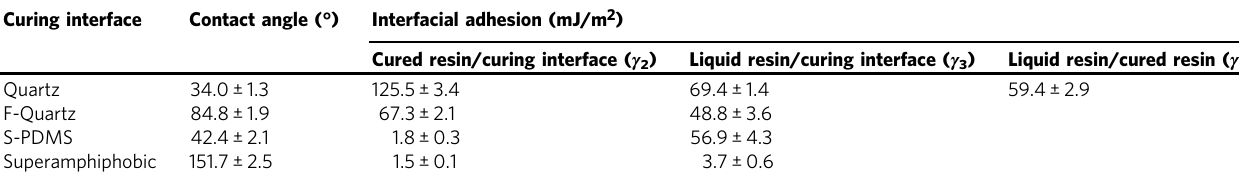
Table 1 The in fl uence of curing interface property on the interfacial adhesion of the three involved interfaces. Curing